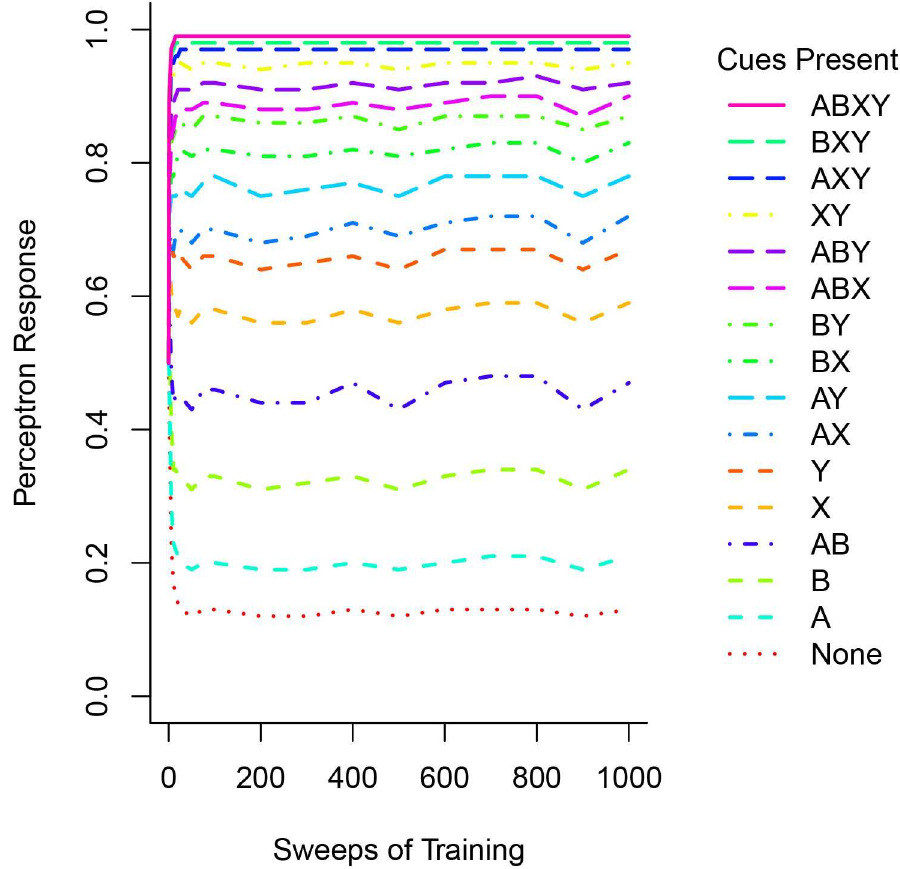
Fig 1. The responses of a perceptron to each of the 16 types of input patterns over the course of 1000 epochs of training. Responsesare recorded after 1, 5, 10, 15, 20, 25, 50, 75, and 100 epochs, and then are recordedevery 100 epochs until 1000 epochs of traininghave been conducted.The legendindicateswhich of the four cues are present in each of the 16 different stimulus patterns; the order of items in the legend matches the order of the lines as they are ‘stacked’ in the